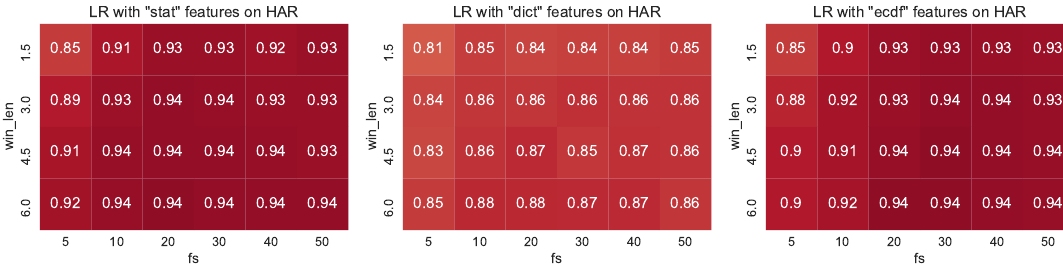
Figure 6. Visualisation of the classification performance on the HAR dataset for stat features ( left ), dict features ( middle ) and ecdf features ( right ) over varying window lengths (rows) and sampling rates (columns). Darker red colours indicate better